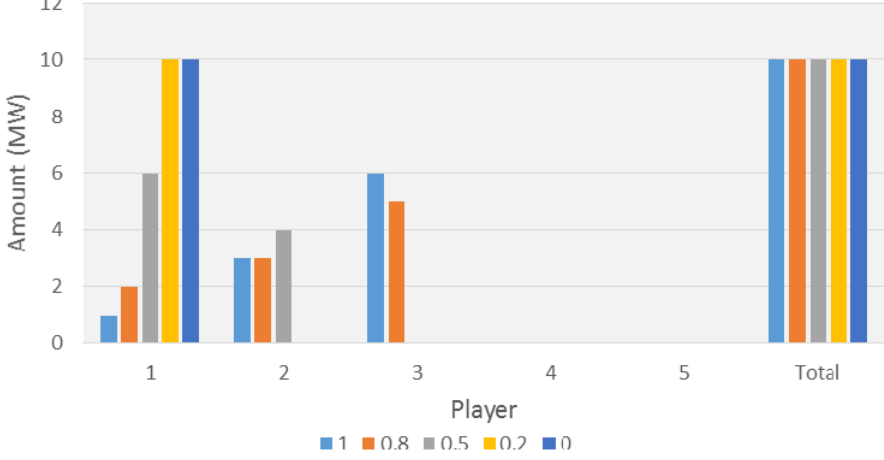
Figure 6. Actions resulting from the Most probable decision method for different